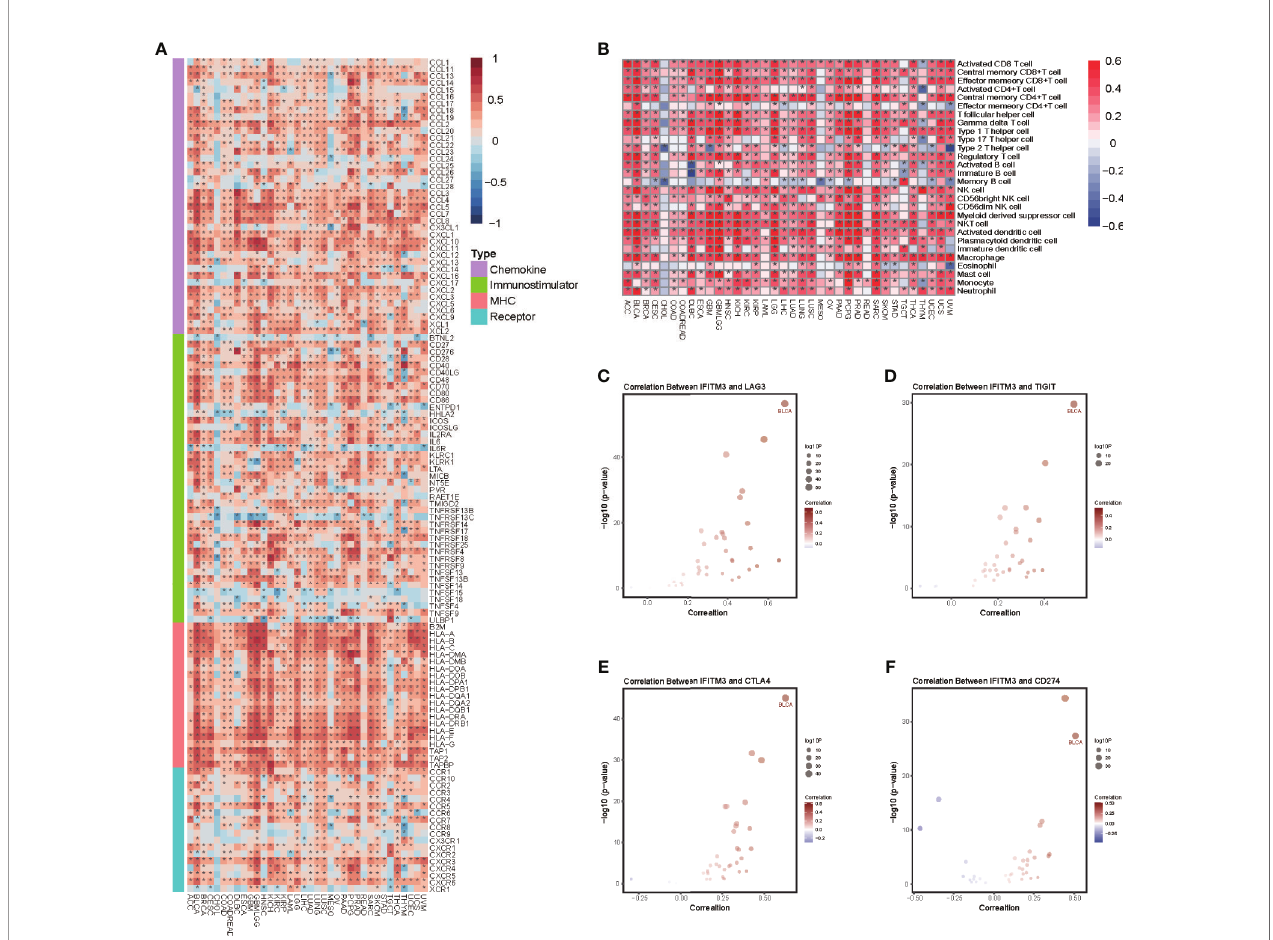
FIGURE 1 | Pancancer analysis of the effect of IFITM3 on immunological status. (A) Correlations between IFITM3 and 122 immunomodulators (chemokines, immunostimulators, MHC, and receptors). The color indicates the correlation coef fi cient. The asterisks indicate signi fi cant differences assessed by Pearson analysis. (B) Correlations between IFITM3 and 28 TIICs calculated with the ssGSEA algorithm. The color indicates the correlation coef fi cient. The asterisks indicate signi fi cant differences assessed by Pearson analysis. Correlation between IFITM3 and 4 immune checkpoints, (C) LAG3, (D) TIGIT, (E) CTLA4, and (F) CD274. The dots represent cancer types. The y -axis represents the Pearson correlation coef fi cient, while the x -axis represents ×log 10 ( p